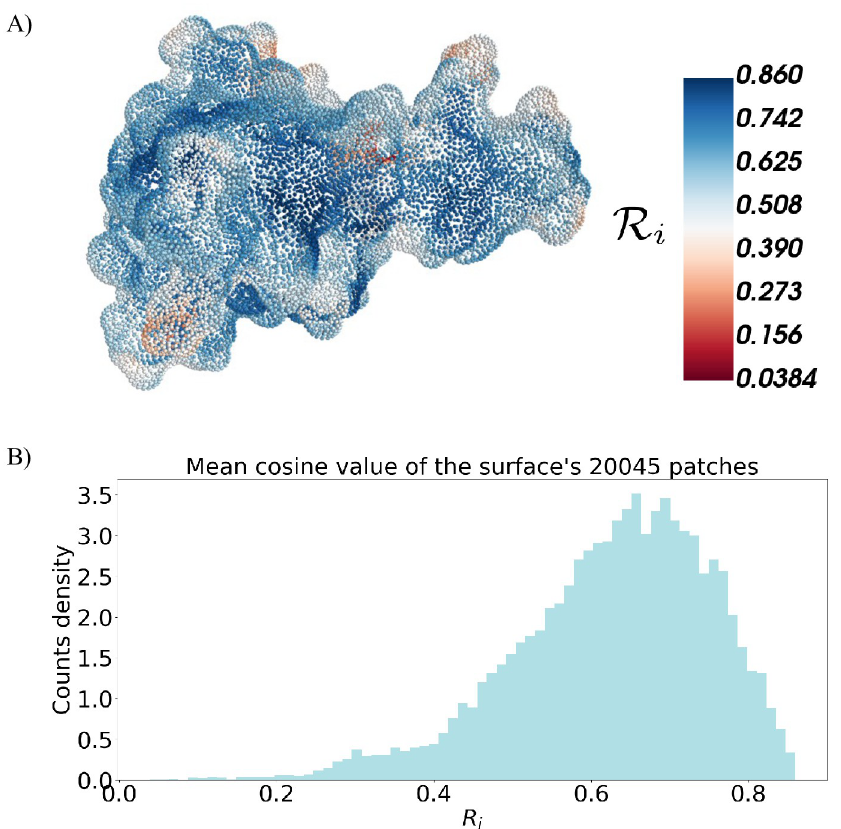
Fig 1. Local roughness of the patches. A) Discretized representation of a molecular surface of the TDP-43 fragment 209-269 (PDB id: 4BS2). Each point of the surface is coloured according to the local roughness value, R Distribution of the roughness R found for each point i of the considered i